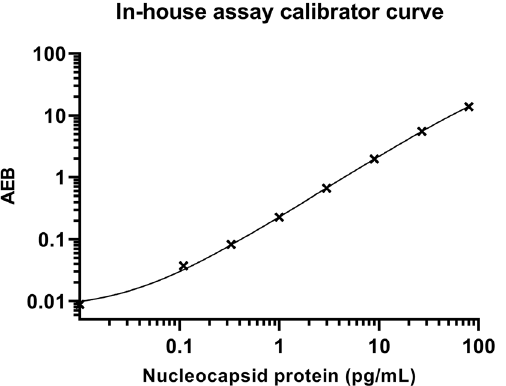
Figure 1. The calibrator curve of the in-house assay. The average number of enzyme per bead (AEB) against the concentration of nucleocapsid protein. Eight calibrators starting at 80 pg/mL and diluted using a threefold dilution. The calibrators were analyzed in duplicates and the mean values are depicted. The calibrator curve was a four parametric curve fit. The LOD was determined to be 0.02 pg/mL.